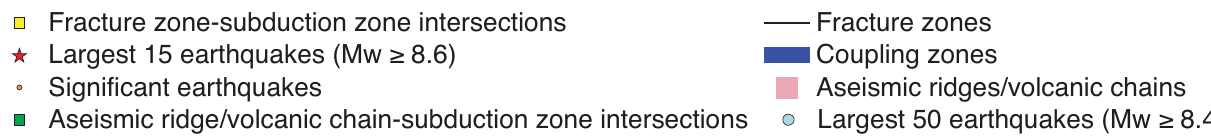
Fig. 1. Data sets used in this study superimposed on the ETOPO1 global relief model (Amante et al., 2009), on a Robinson projected map: subduction coupling zones (blue bands) (see text for coupling zone model description), oceanic fracture zones (dark gray) and oceanic volcanic chains and aseismic ridges (pink) (Matthews et al., 2011), intersection points of fracture zones with subduction zones (yellow squares), intersection points of the volcanic chains and ridges with subduction zones (green squares), largest 15 instrumentally recorded earthquakes ( M w ≥ 8 . 6) (red stars), largest 50 earthquakes ( M w ≥ 8 . 4) (light blue circles), and all other significant earthquakes (small beige circles) (NGDC/WDC, 2011). Inv FZ, Investigator Fracture Zone, Krus FZ, Krusenstern Fracture Zone, Phil SZ, Philippine Subduction Zone, Mar SZ, Marianas Subduction Zone, SW-P SZ, Southwest Pacific Subduction Zone, Jap SZ, Japan Subduction Zone, Kam SZ, Kamchatka Japan Subduction Zone, Aleu SZ, Aleutian Subduction Zone, Cas SZ, Cascadia Subduction Zone, C-Am SZ, Central America Subduction Zone, S-Am SZ, South America Subduction Zone, L-An SZ, Lesser Antilles Subduction